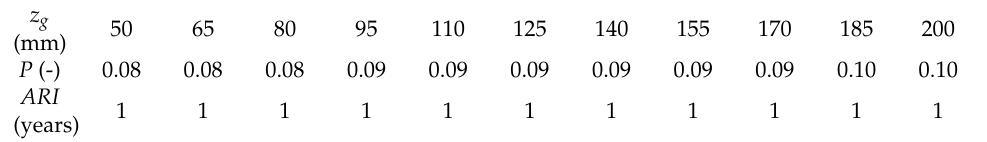
Table 10. Analysis results in summer, GREEN ROOF